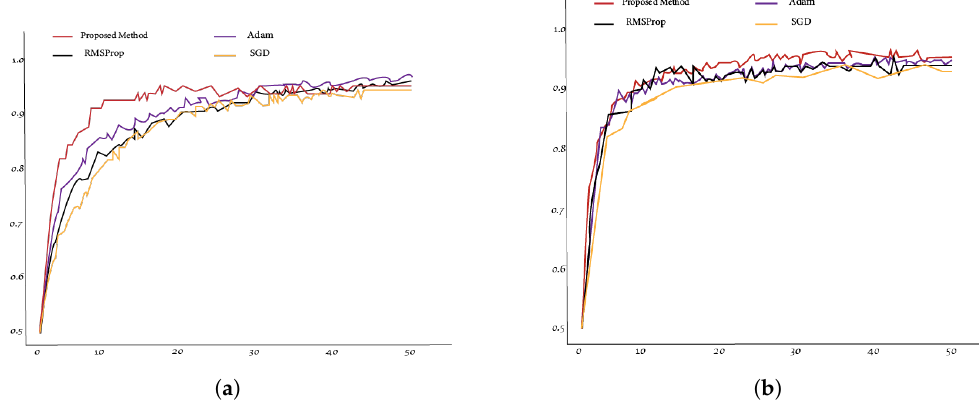
Figure 5. Training and testing of ResNet50 with various optimizers on the CIFAR-100 dataset. ( a ) Training accuracy. ( b ) Testing accuracy.